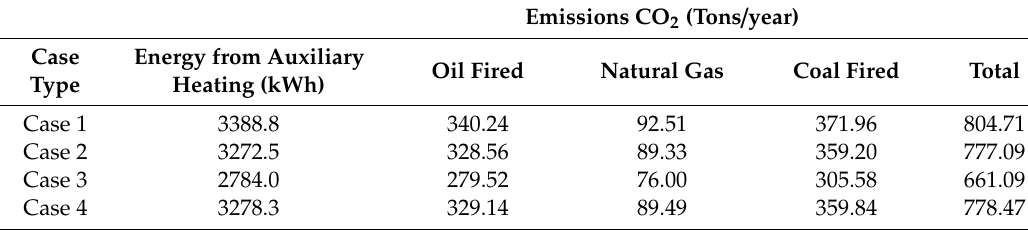
Table 8. CO 2 emissions for every case.